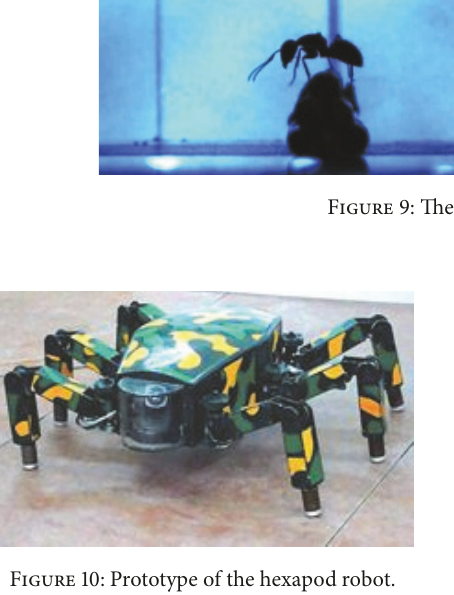
Figure 10: Prototype of the hexapod robot.